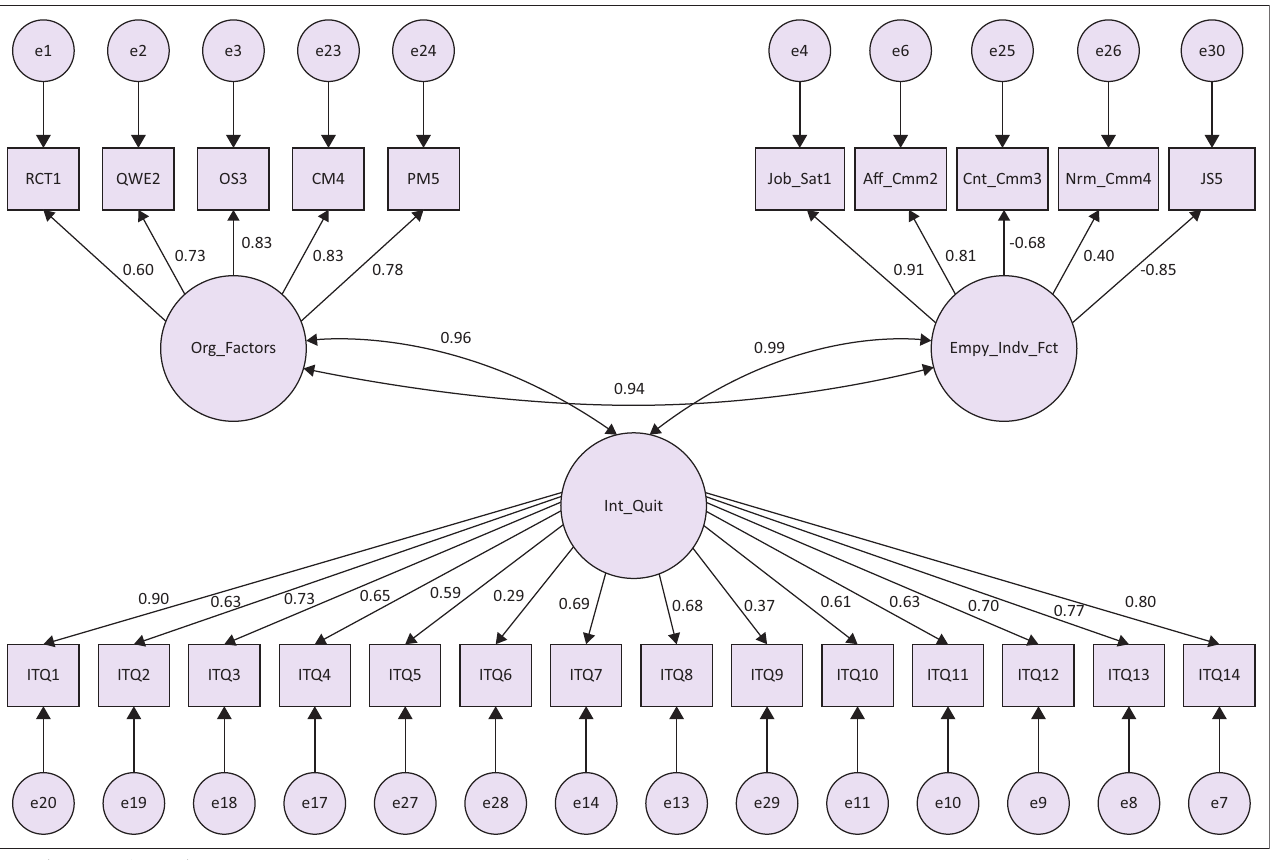
FIGURE 2: Unimproved (initial) measurement